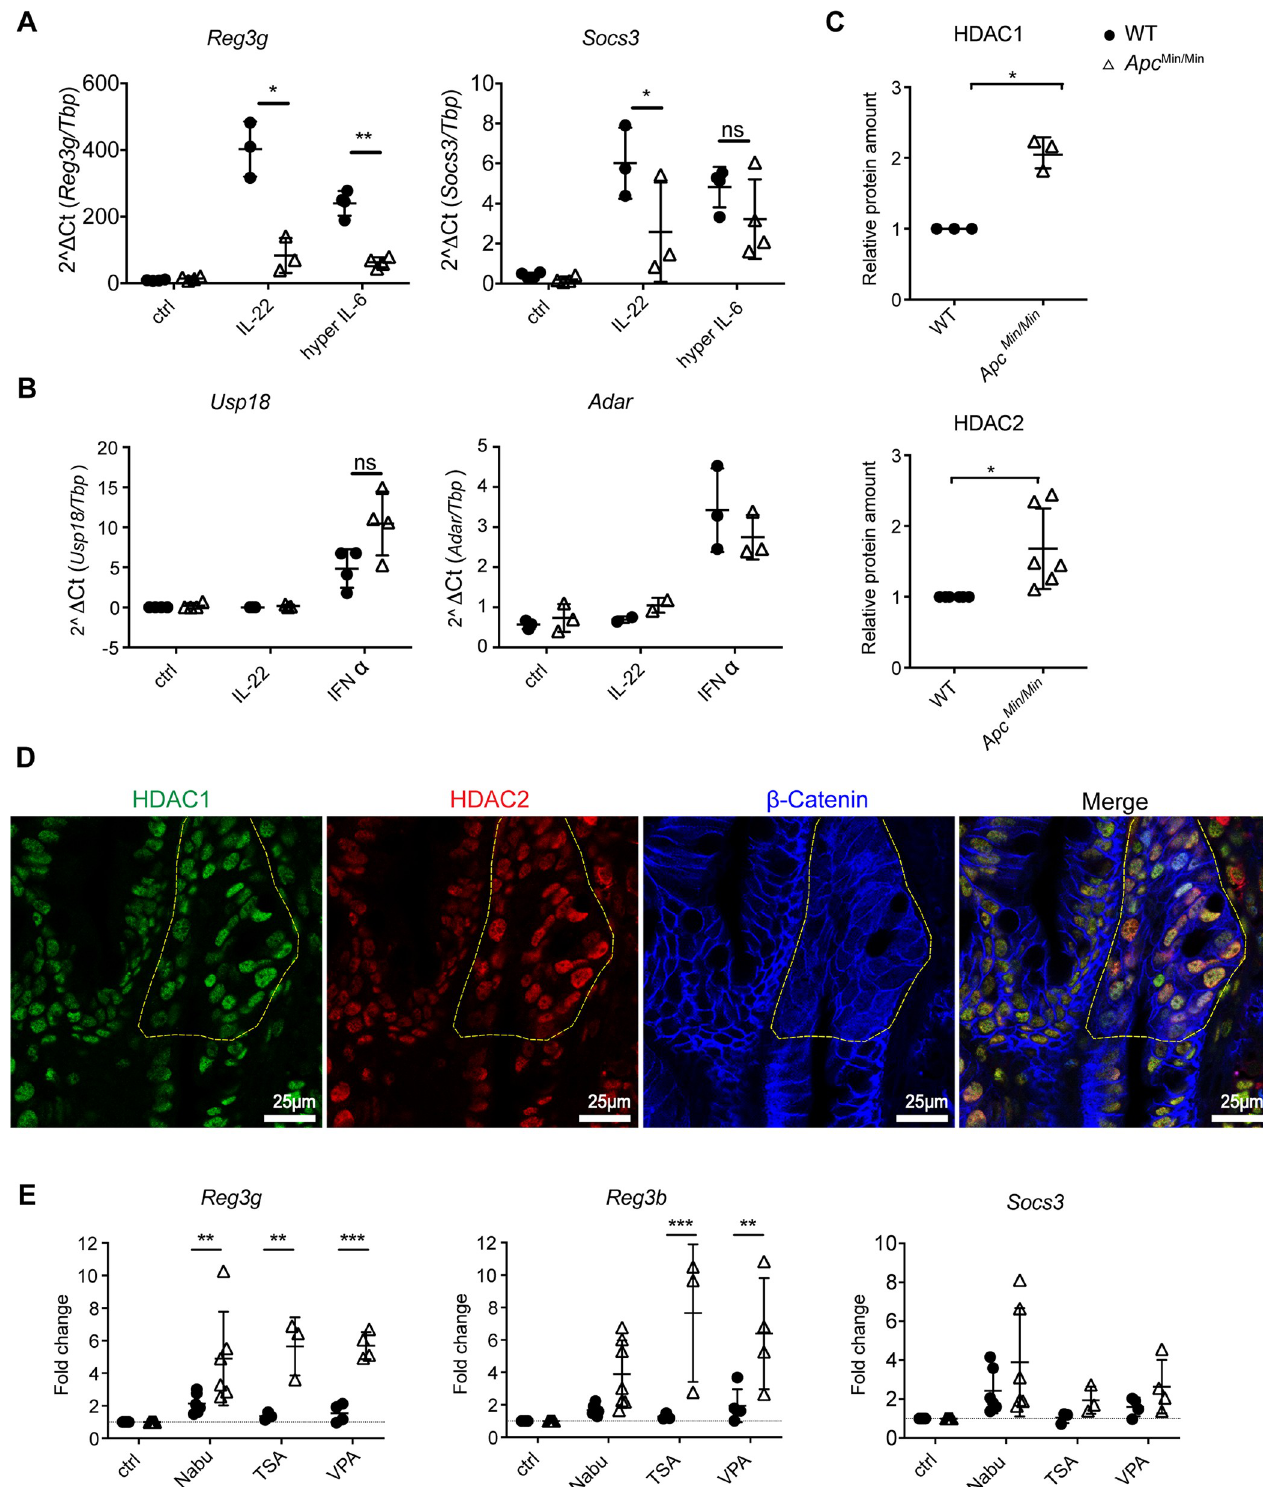
Fig 5. HDAC inhibition partially rescues STAT3-mediated gene transcription in Apc Min/Min organoids. (A) RT-qPCR analysis of WT and Apc Min/Min organoids treated with IL-22 (10 ng/ml) or hyper IL-6 (50 μ M) for 3 hours. Data show mRNA expression of STAT3 target genes, Reg3g or Socs3 , relative to Tbp . (B) RT-qPCR analysis for WT and Apc Min/Min organoids treated with IL-22 (10 ng/ml) or IFN α (1,000 U/ml) for 3 hours. Data show the expression of STAT1